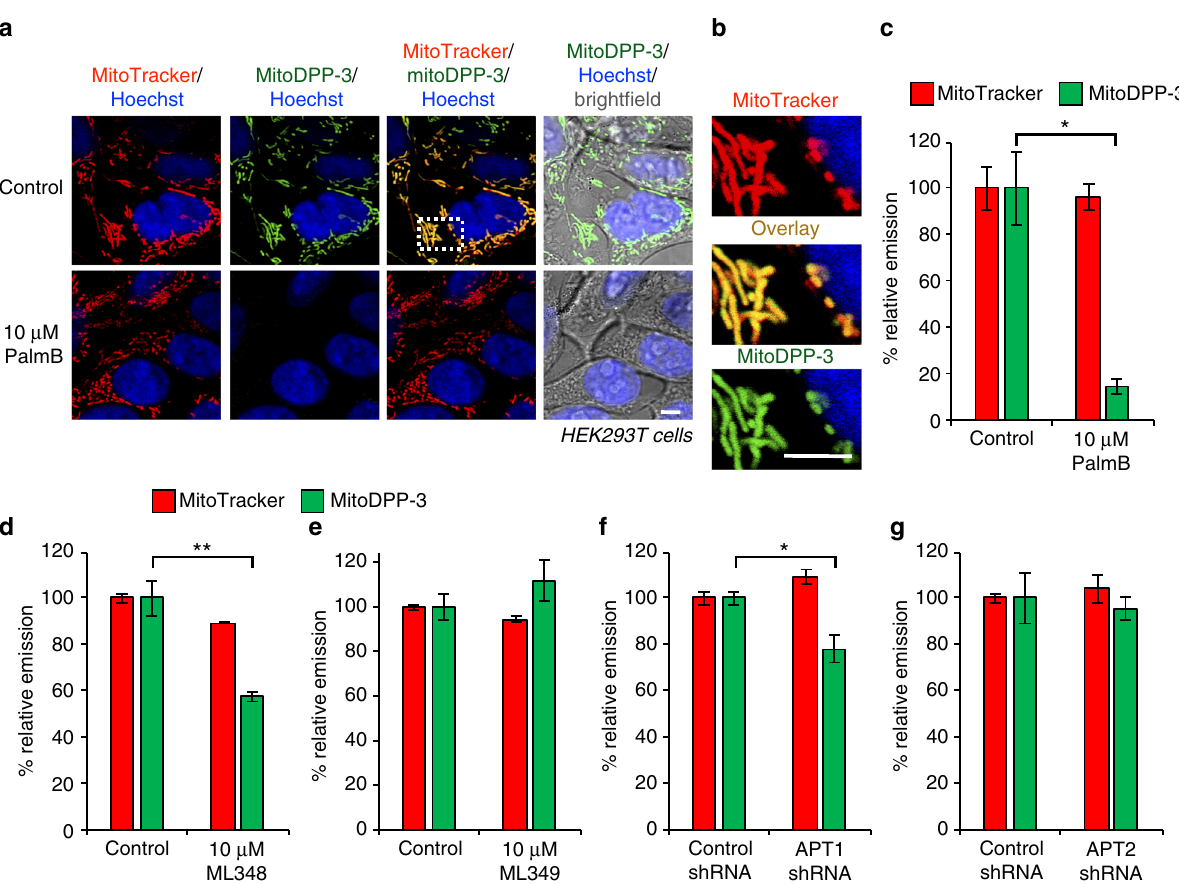
Fig. 6 MitoDPP-3 reveals APT1 activity in mitochondria. a HEK293T cells treated for 30 min with 1 µ M Hoechst 33342, 100 nM MitoTracker Deep Red, and either DMSO or 10 µ M PalmB for 30 min, washed, loaded with 324 nM mitoDPP-3 for 10 min, and then analyzed by confocal fl uorescence microscopy. 5 µ m scale bars shown. b Enlarged portion of image indicated by dotted white box in ( a ) showing colocalization of mitoDPP-3 with MitoTracker. Quanti fi cation of the relative fl uorescence intensity from mitoDPP-3 and MitoTracker in either control or PalmB-treated cells ( c ). ML348-treated cells ( d ), ML349-treated cells ( e ), cells with APT1 knocked down ( f ), or cells with APT2 knocked down ( g ). For all plots, statistical analyses performed with a two- tailed Student ′ s t -test with unequal variance, * P value < 0.05; ** P value < 0.009, n = 3 for ( c ), n ≥ 4 for ( d – g ), error bars are ±